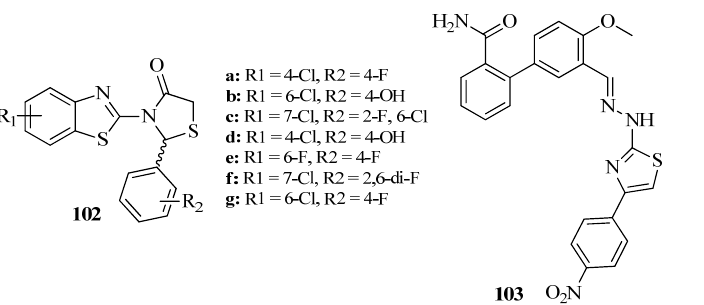
Figure 40. Structures of benzothiazole-based thiazolidin-4-ones and biphenylhydrazo 4-arylthiazoles derivatives.